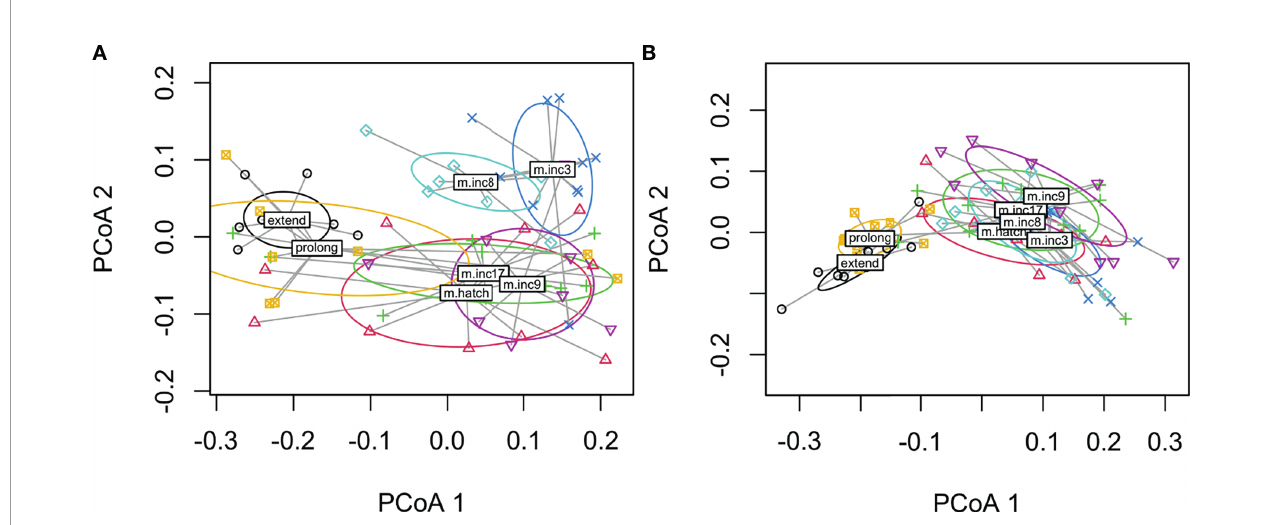
FIGURE 6 | Dispersion plots of fi ve hormones in male (A) and female (B) rock doves by experimental manipulation treatment (m.inc3 = remove eggs at clutch completion, m.inc9 = remove eggs at mid-incubation, m.inc17 = remove eggs at late incubation, m.hatch = remove nestlings at hatching, m.inc8 = reduce incubation period to 9d, prolong = prolong incubation to 21d and extend = extend length of time to